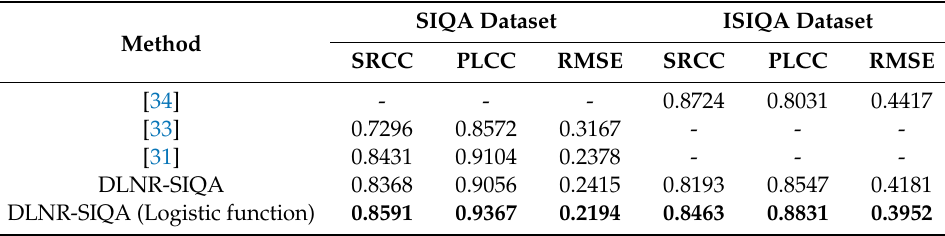
Table 3. Comparison of our proposed DLNR-SIQA with di ff erent SIQA methods.